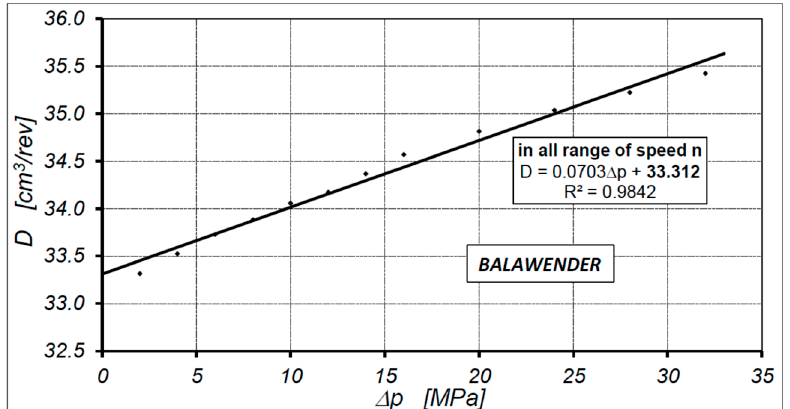
Figure 14. Characteristics of D = f ( Δ p) (Balawender’s method).